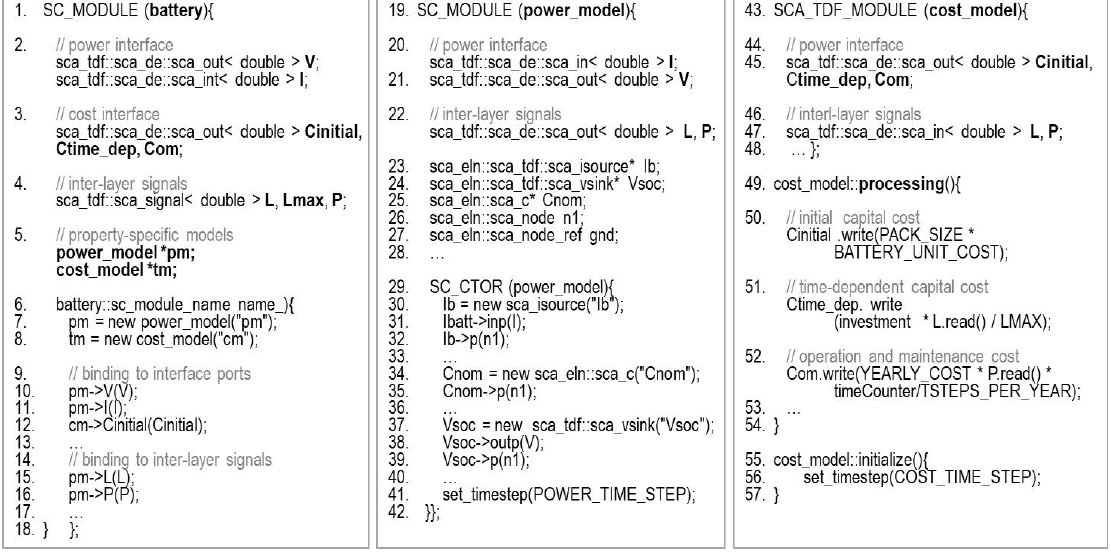
Figure 4. Example of SystemC-AMS of a battery: top level module ( left ), power model, implementing a circuit model in ELN ( center ), and a cost model ( right